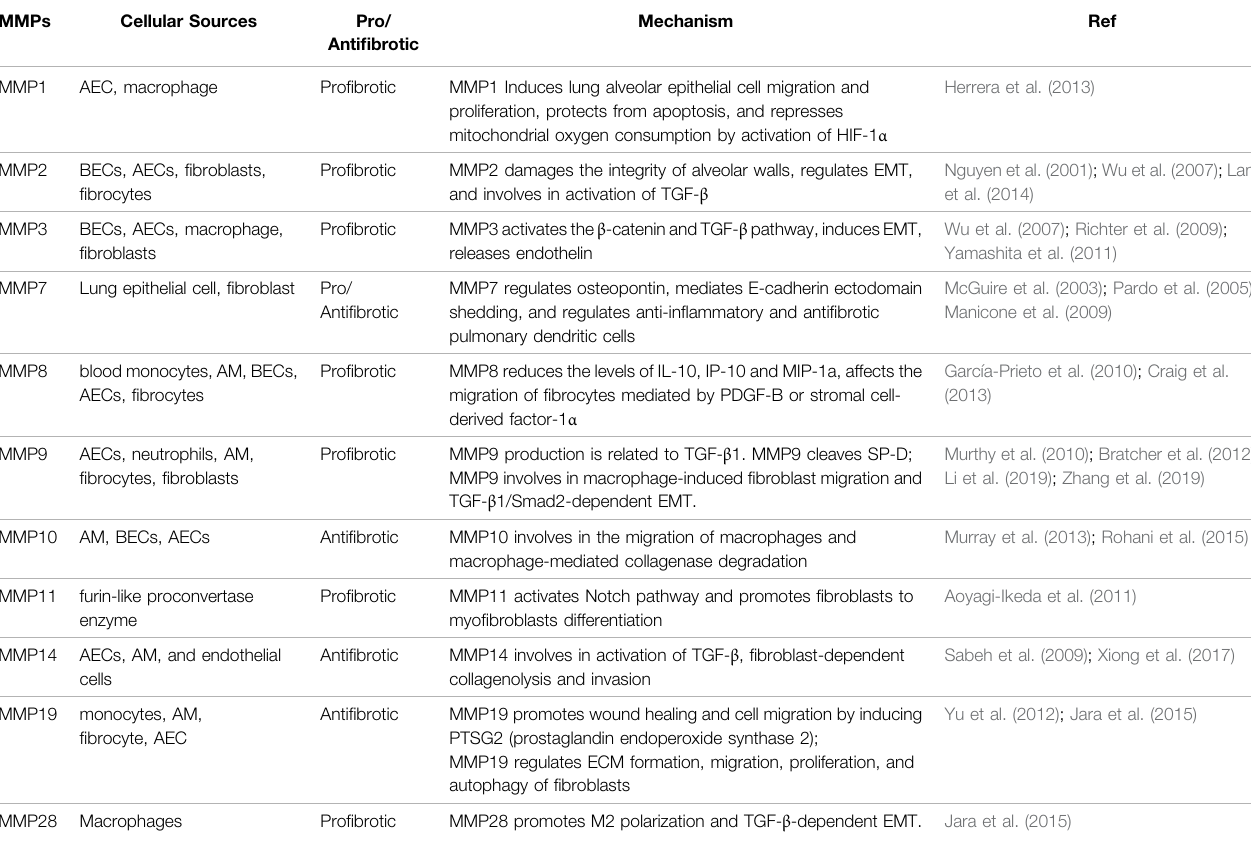
TABLE 1 | The potential role of MMPs/TIMPs in